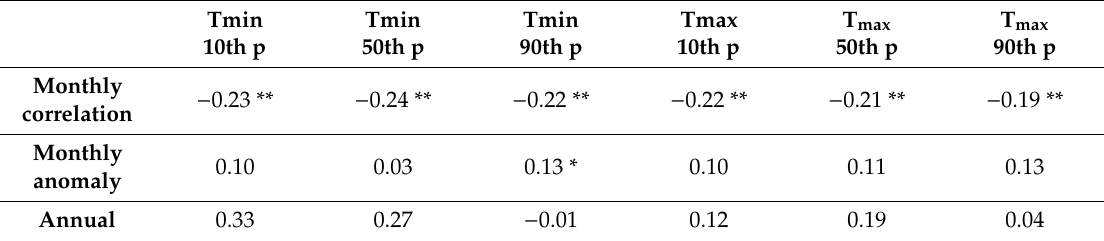
Table 1. Correlation of the monthly time series of KD onsets in Emilia with local monthly climate indices of 10th, 50th, and 90th percentile of minimum and maximum temperature obtained from full fields and anomalies and for their annual mean values. Tmin Tmin Tmin Tmax T max T max 10th p 50th p 90th p 10th p 50th p 90th p